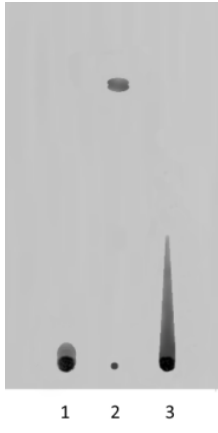
Figure 5. TLC chromatogram of complex [N-VP] n -[N-VA] m [1,4- and 6,3-GL]: 1) copolymer [N-VP] n - [N-VA] m ; 2) mixture of 1,4- and 6,3-GL; 3) polymer complex [N-VP] n -[N-VA] m [1,4- and 6,3-GL].